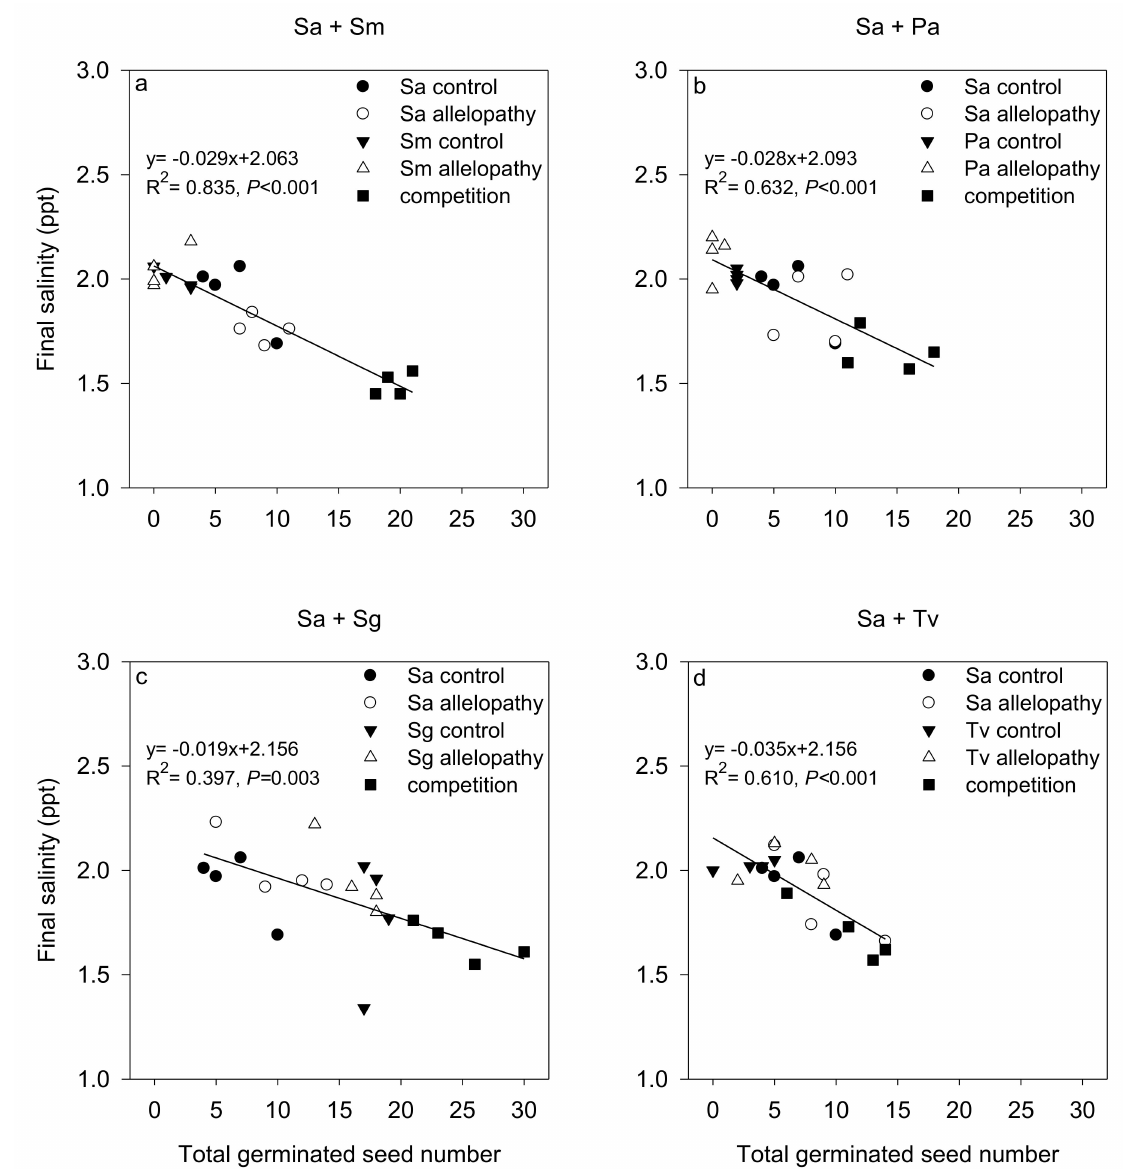
Figure 5. Relationship between final salinity of the solution in Petri dishes after germination and total germinated seed number in different interspecific interaction treatments (control: target species in monoculture, allelopathy: target species seeds + competitor seeds leachate, competition: target species seeds + competitor seeds in mixture). ( a ) Species combination of Sa + Sm, ( b ) Species combination of Sa + Pa, ( c ) Species combination of Sa + Sg, ( d ) Species combination of Sa + Tv. Sa: Spartina alterniflora , Sm: Scirpus mariqueter , Pa: Phragmites australis , Sg: Suaeda glauca , Tv: Tripolium vulgare